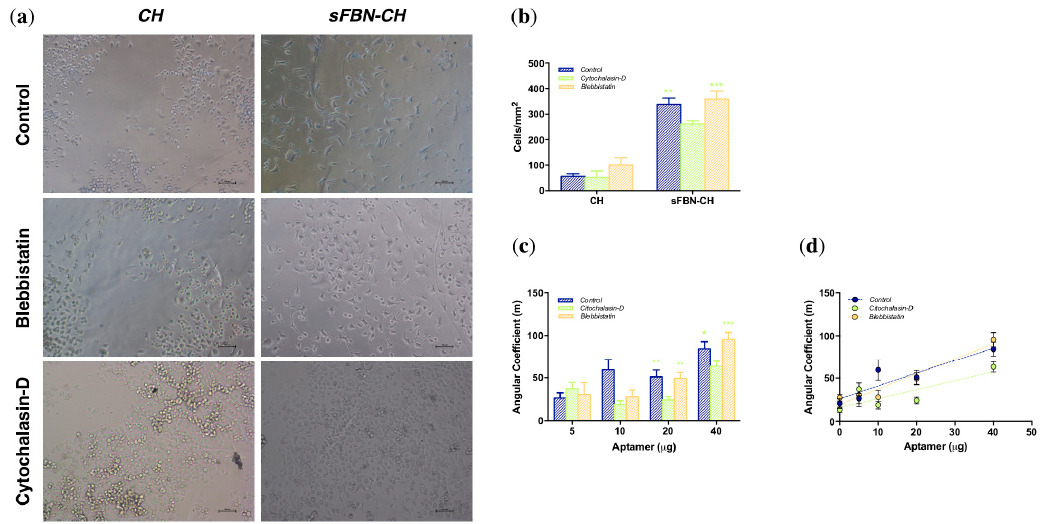
Figure 4. HeLa cells spreading modulation on sFBN-CH by cytochalasin-D and blebbistatin. ( a )